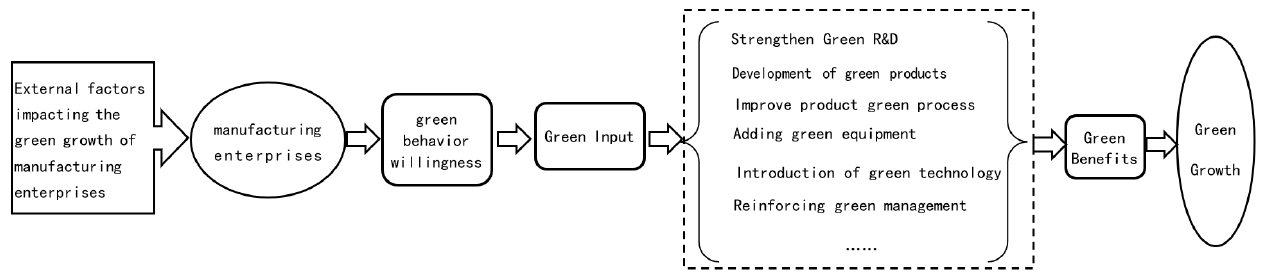
Figure 1. Conceptual model of the main factors influencing green growth.